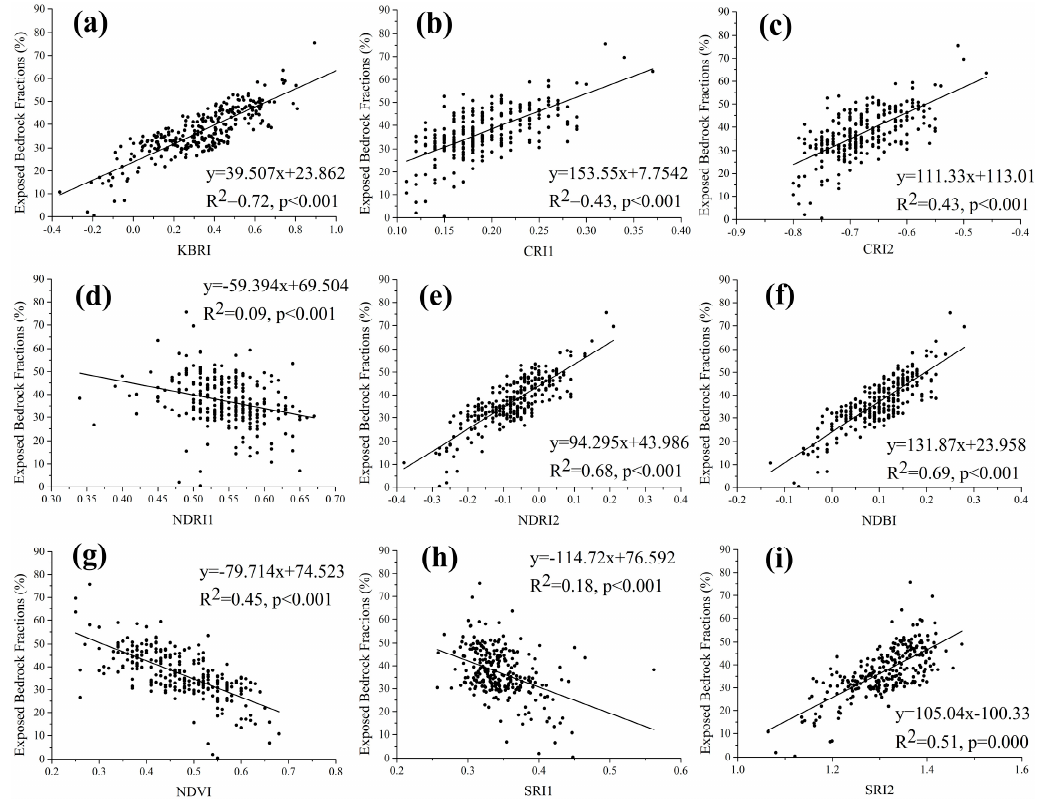
Figure 4. The linear relationships between the related indices and exposed bedrock fractions in the Xiaojiang watershed. ( a ) KBRI; ( b ) CRI1; ( c ) CRI2; ( d ) NDRI1; ( e ) NDRI2; ( f ) NDBI; ( g ) NDVI; ( h ) SRI1; ( i ) SRI2.